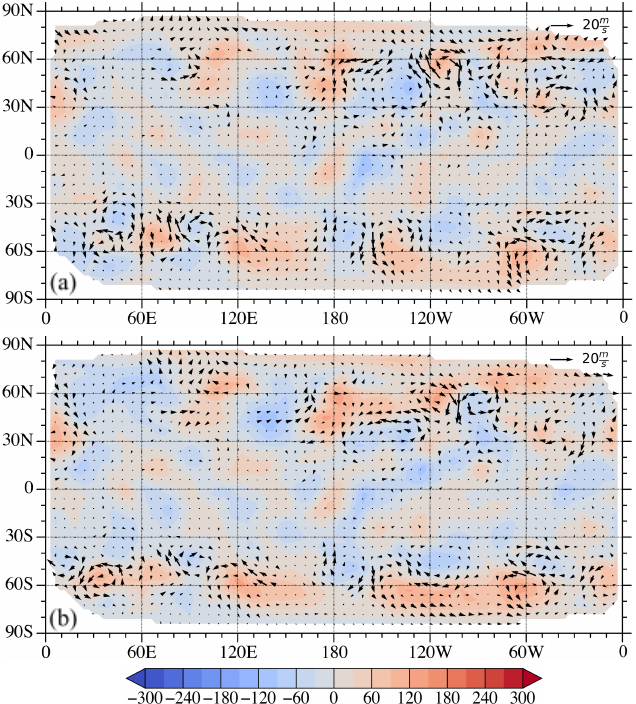
Figure 9. Differences in 2-day forecasts ( a ) between the control experiment and referenced high resolu- Fig. 9: Differences in 2-day forecasts (a) between the control experiment and referenced high tion simulations and ( b ) between the DA experiment and the referenced high-resolution resolution simulations and (b) between the DA experiment and the referenced high-resolution simulations.